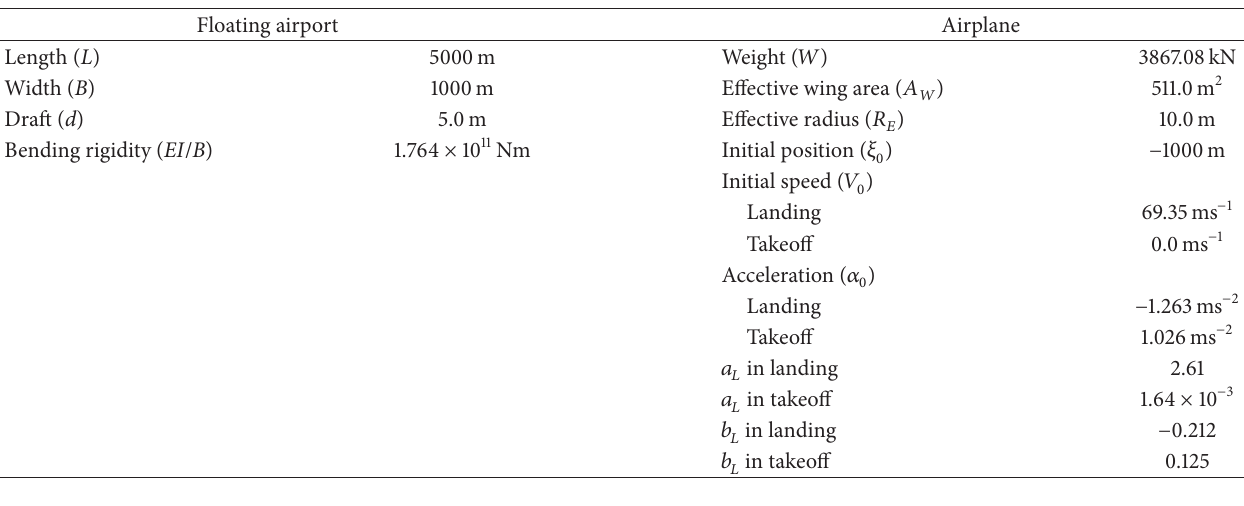
Table 2: Main parameters of landing/takeoff run.